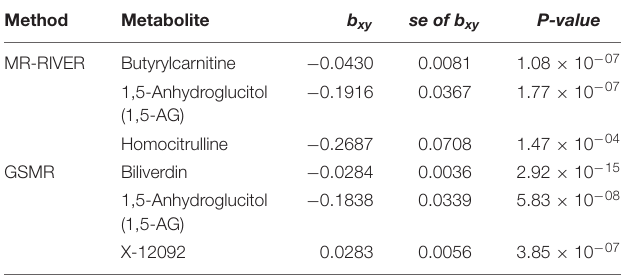
TABLE 1 | Relative bias of imputed datasets with three imputation methods.